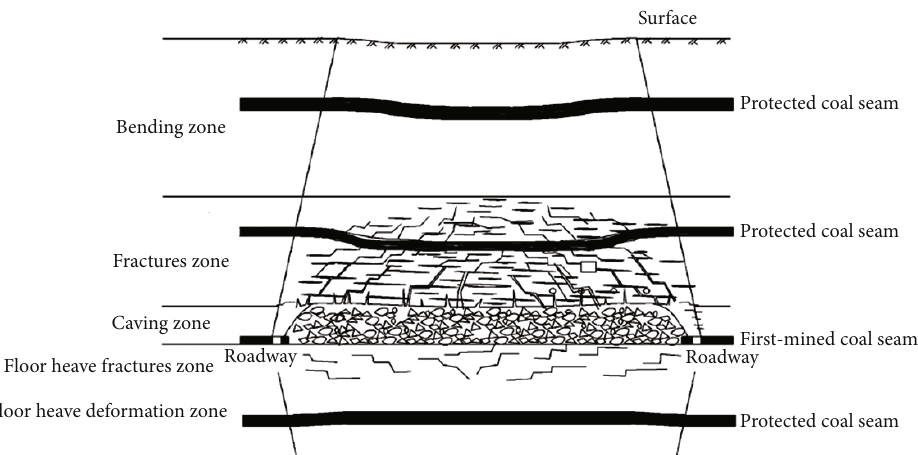
Figure 13: Deformation and fracture of protected coal seams in the process of mining protection coal seams